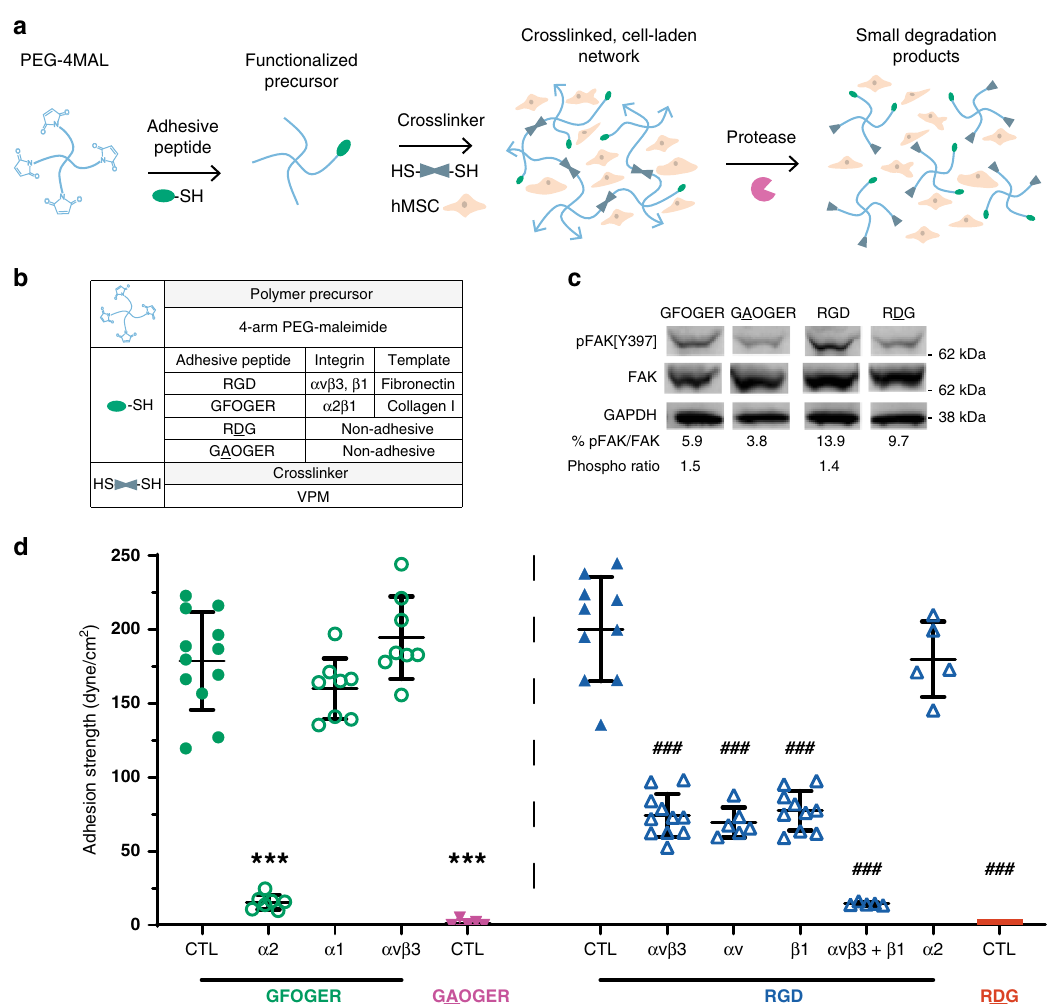
Fig. 1 Integrin-speci fi c peptide-functionalized hydrogels modulate cell adhesion. a 4-arm PEG-maleimide hydrogel reaction scheme (cells not shown to scale relative to hydrogel). b Hydrogel components. c Western blot for FAK phosphorylation indicates integrin activation of encapsulated hMSC. hMSCs exhibited 1.5- and 1.4-fold greater phosphorylation of FAK at Y397 when encapsulated in hydrogels functionalized with adhesive GFOGER and RGD peptides, compared with inactive peptides, GAOGER and RDG, respectively. For all blots, two-color imaging of the same membrane was performed using different species antibodies for FAK and pFAK, and the loading control GAPDH was run on the same membrane. Representative blots from three biologically independent runs are shown. d Adhesion strength values for hMSC adhering to hydrogels in the presence or absence of blocking antibody. Each point represents a biologically independent sample (sample size: GFOGER CTL = 12, GFOGER α 2 = 7, GFOGER α 1 = 8, GFOGER α v β 3 = 8, GAOGER CTL = 5, RGD CTL = 10, RGD α v β 3 = 11, RGD α v = 6, RGD β 1 = 10, RGD α v β 3 + β 1 = 5, RGD α 2 = 5, RDG CTL = 4), mean ± SD. ANOVA ( p < 0.0001) was used to detect statistical differences followed by Sidak ’ s multiple comparisons test with adjustment for multiple comparisons, *** p < 0.0001 vs. GFOGER CTL; ### p < 0.0001 vs. RGD demonstrates that α 2 integrin mediates adhesion to GFOGER. The α 2 subunit only dimerizes with β 1 integrin, thus we conclude that hMSC adhesion to GFOGER-presenting gels is mediated by α 2 β 1 integrin. For RGD-presenting gels, antibodies against α V, α V β 3, and β 1 integrins individually reduced adhesion strength by ~60 – 65%, which is higher than background adhesion levels on RDG-presenting gels. Blocking both α V β 3 and β 1 integrins completely eliminated adhesion to RGD-presenting gels. Impor- tantly, α 2-blocking antibody had no effects on the adhesion strength to RGD-presenting gels. These results show that α V β 3 and β 1 integrins, but not α 2 β 1 integrin, mediate cell adhesion to RGD- presenting gels. These results demonstrate that hMSC adhesion to GFOGER- ( α 2 β 1 integrin) and RGD- ( α V β 3/ β 1 integrins) present- ing gels is integrin speci fi c. In addition, there is negligible hMSC adhesion to gels presenting the inactive peptides GAOGER and RDG.